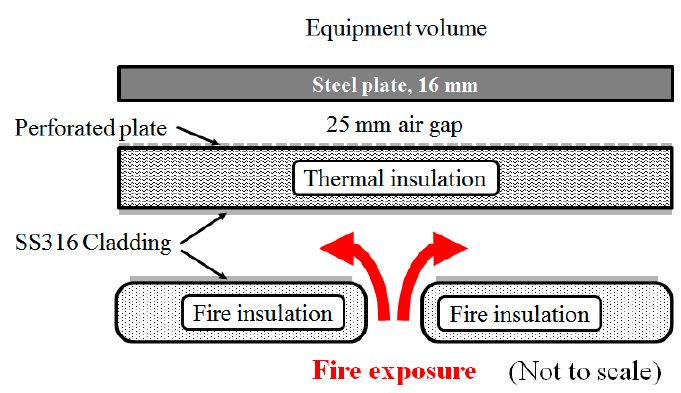
Figure 3. Conceptual sketch 2 of the test set-up where the exposed cladding views heat exposed neighbor objects (fire insulated cladding).